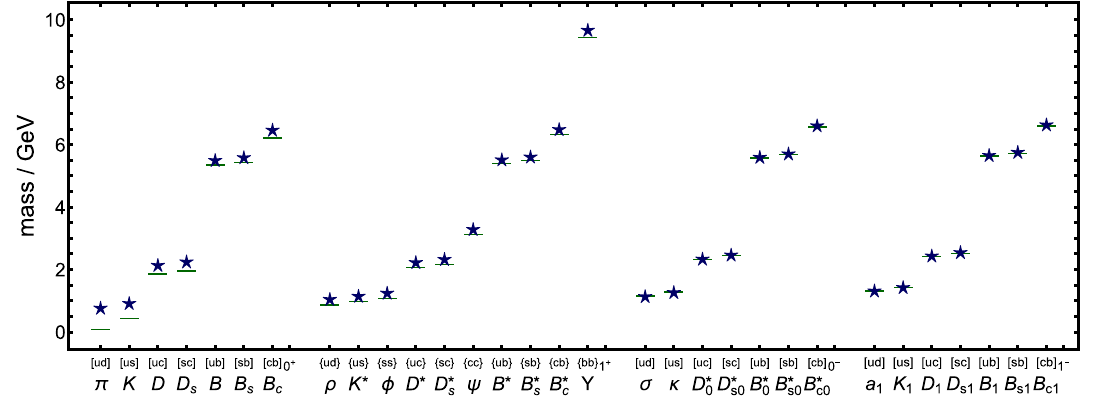
Fig. 3 Computed masses of diquark correlations and their symmetry-related meson counterparts: diquarks – (blue) stars and mesons – (green) bars. (Pictorial representation of Table 2) Table 2 Diquark correlations: computed masses (GeV) and Bethe–Salpeter amplitudes of scalar, axial-vector, pseudoscalar and vector diquarks. N.B . We work in the isospin-symmetry limit; so, e.g. [ ds ] 0 + = [ us ] 0 + J P